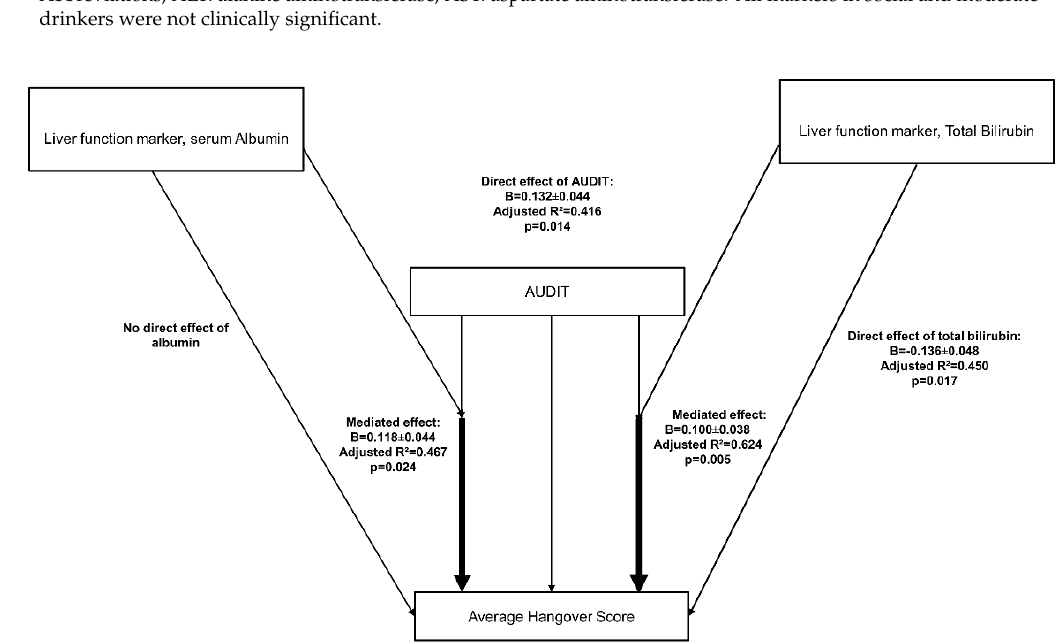
Table 3. Presentation of candidate liver panel markers.